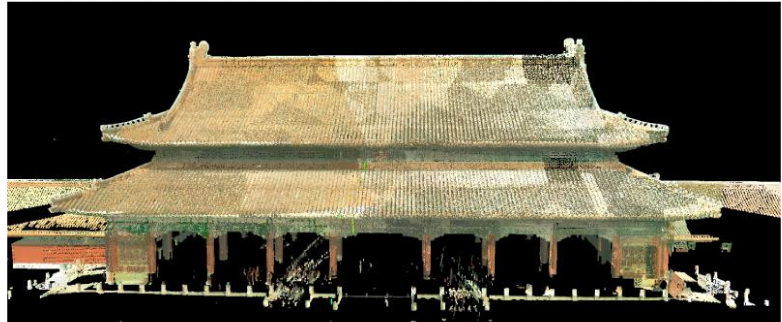
Figure 10. The final point cloud data obtained using an unmanned aerial vehicle (UAV) and digital camera.